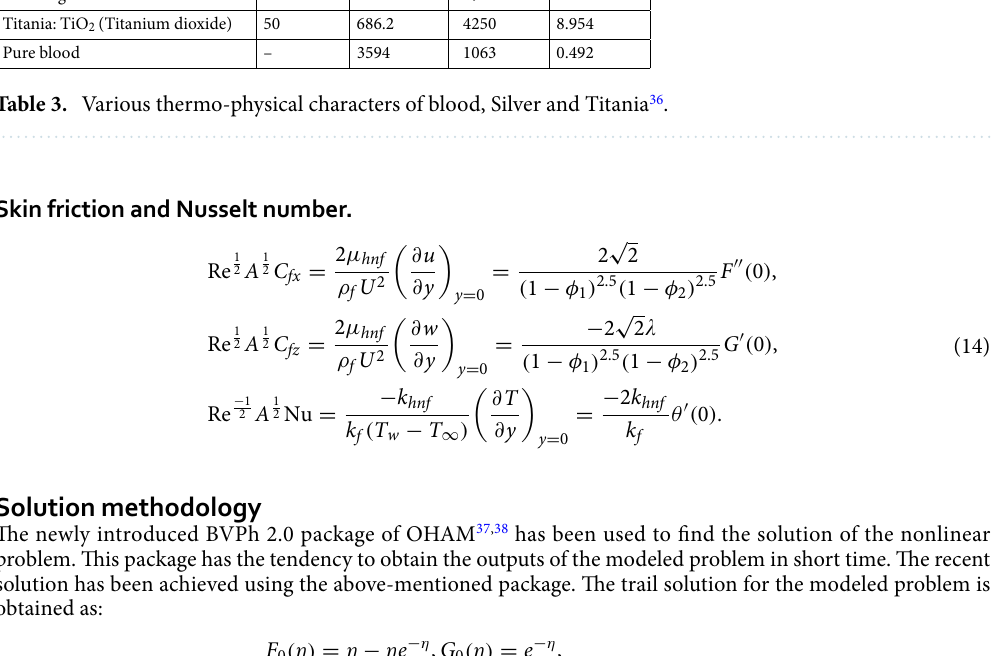
Thermo-physical